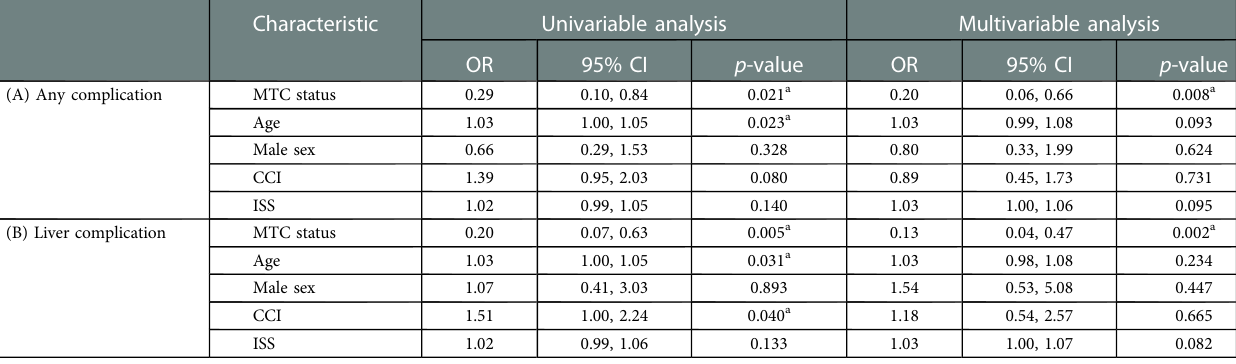
TABLE 4 Odds ratio of having (a) any complications and (b) liver complications according to MTC status adjusted for potentially confounding patient and injury characteristics for patients with high grade liver trauma (AAST grade IV or V).